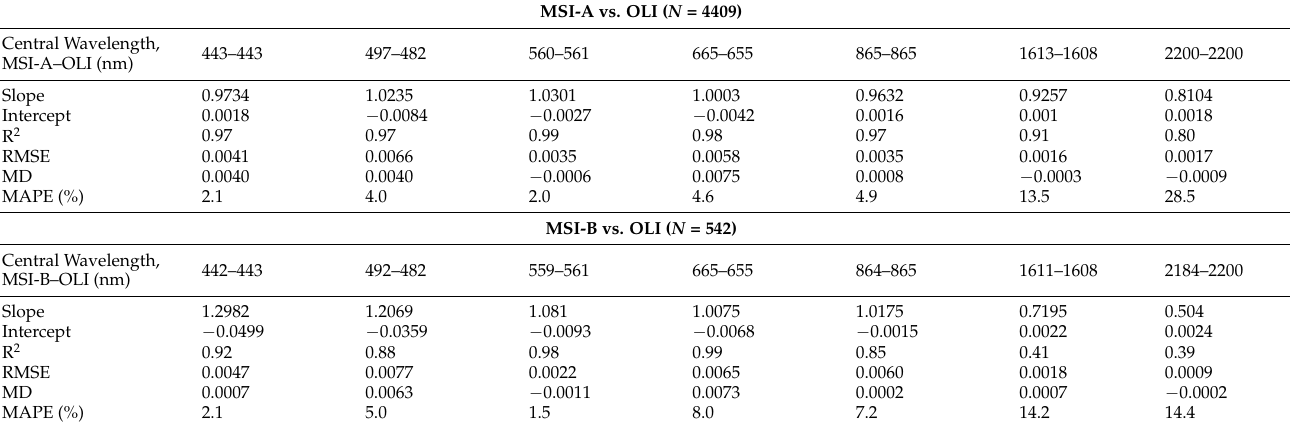
Table 3. Intercomparison of unitless ρ t after vicarious